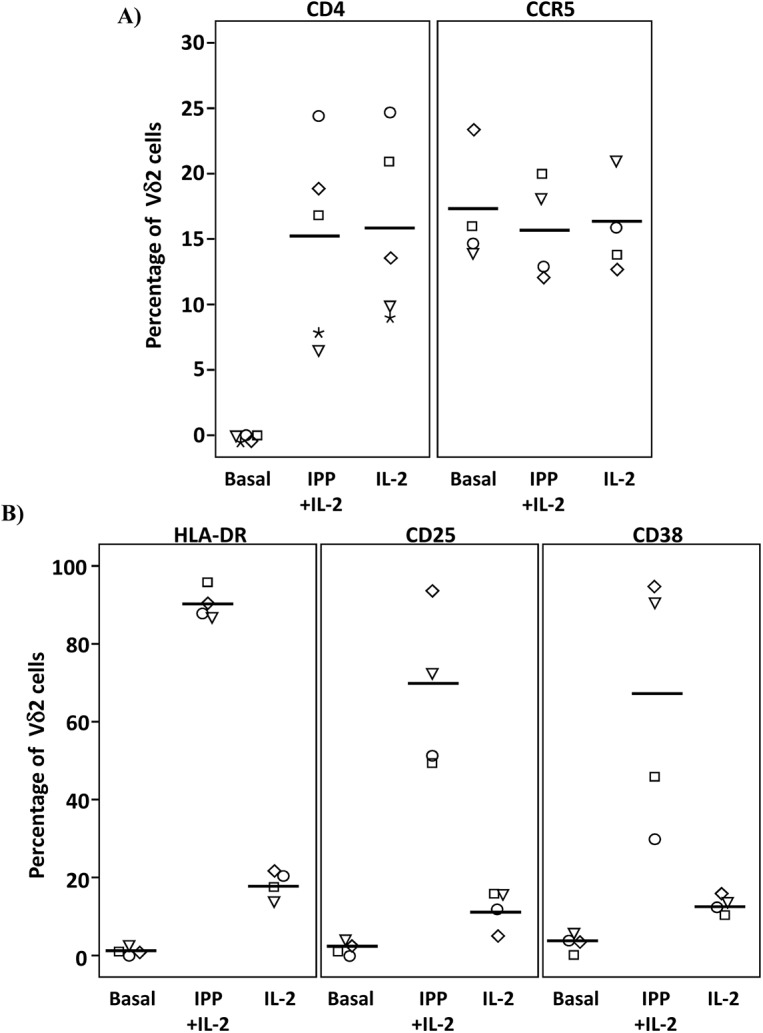
Expression of CD4, CCR5 and activation markers on Vδ2 cells.PBMC from HIV-uninfected donors were cultured and treated with IL-2 alone or IPP and IL-2 for six days. The surface expression of CD4, CCR5, and activation markers (HLA-DR, CD38 and CD25) on Vδ2 cells were analyzed by flow cytometry on days 0 and 6. A) Majority of peripheral Vδ2 cells do not express the CD4 receptor but CD4 is significantly upregulated after six days in culture with IL-2 or with IPP and IL-2 (*p<0.01). However, CCR5 is expressed on the surface of Vδ2 cells at baseline without a significant induction after treatments. B) Analysis of activation markers (HLA-DR, CD25 and CD38) showed peak activation after six days of culture with IPP and IL-2 with moderate activation by IL-2 alone (*p<0.05).